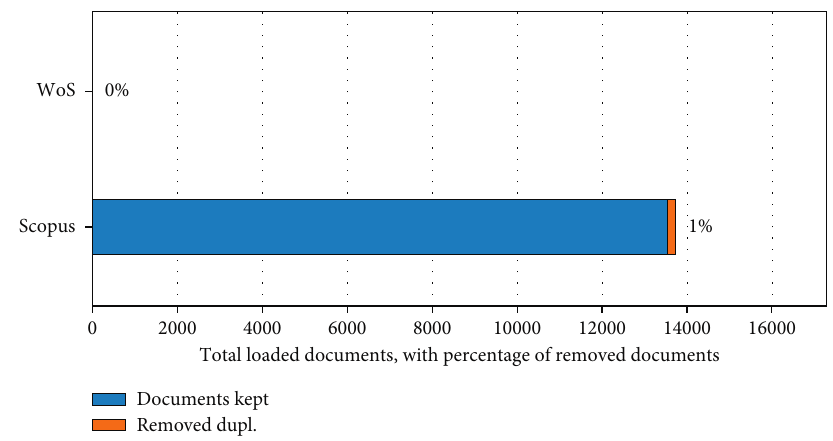
Figure 3: Preprocessing result from ScientoPy.